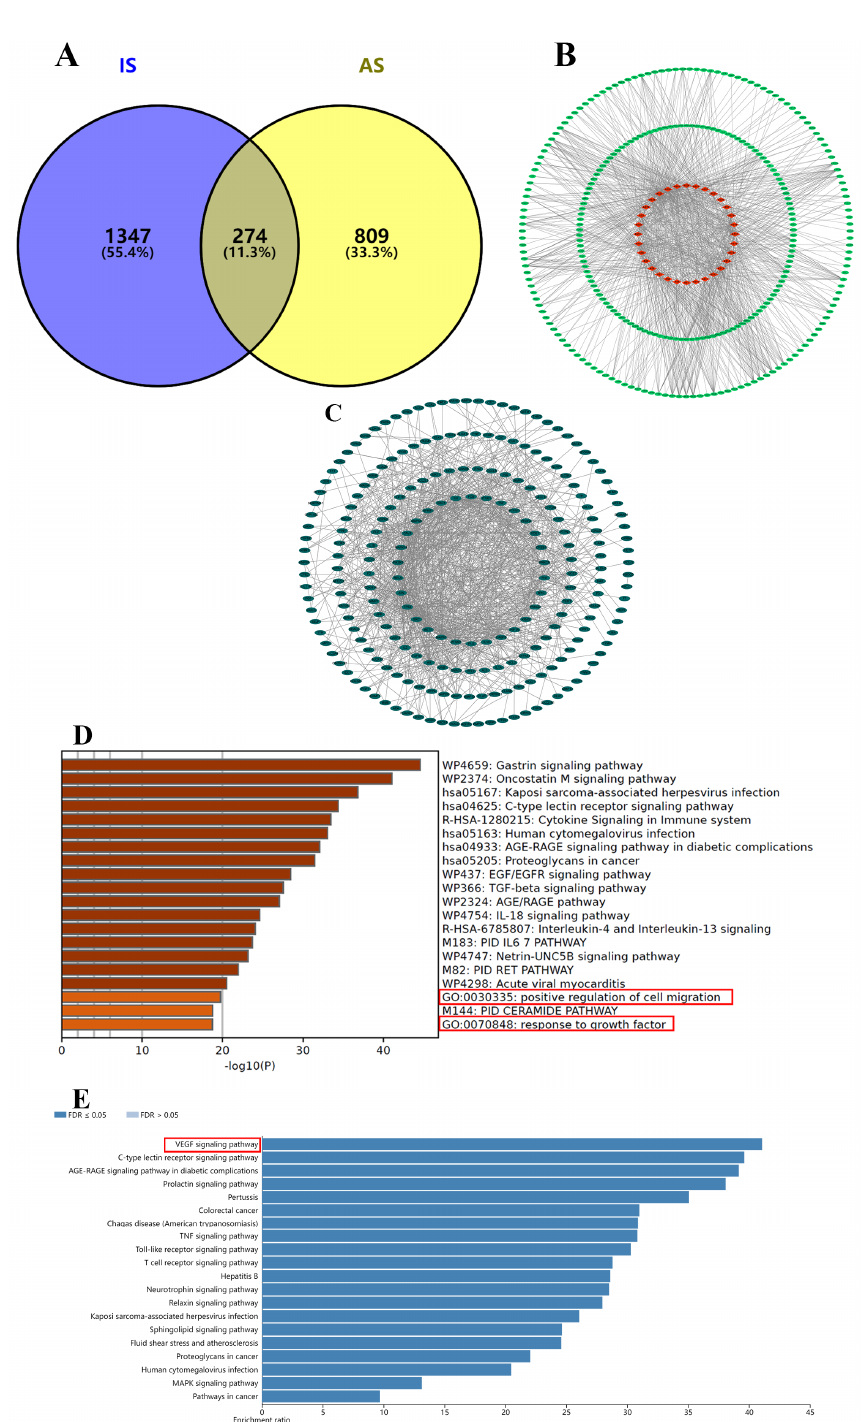
Figure 2. Network pharmacology analysis of AS. ( A ) Venn diagram of AS − related targets and IS − related targets. ( B ) Ingredient − target network of AS against IS. ( C ) The PPI network of 274 mutual targets. ( D ) The top 20 GO terms of core targets. ( E ) The top 20 KEGG pathways of core targets.